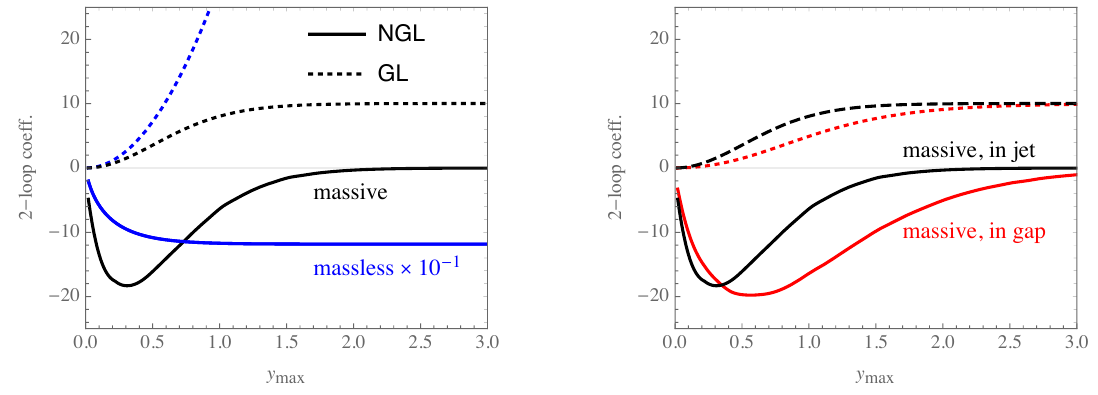
Figure 5 . Size of the two-loop terms in (4.9) as a function of the rapidity y max of the gap region. The global contributions S (2) are shown with dashed lines, the non-global parts S (2) using solid GL NGL lines. The black lines in both panels are identical and correspond to radiation from a massive dipole with (cid:12) i = (cid:12) j = 0 : 5 and a reference vector ~n along the direction of the massive quarks. Left panel: comparison to the massless case. Note that the massless coe(cid:14)cients (blue lines) have been divided by 10 to make their size similar to the massive ones. Right panel: comparison to the same (cid:12) i = (cid:12) j = 0 : 5 dipole with ~n perpendicular to the quarks, corresponding to emissions from a massive quark inside the gap region (red